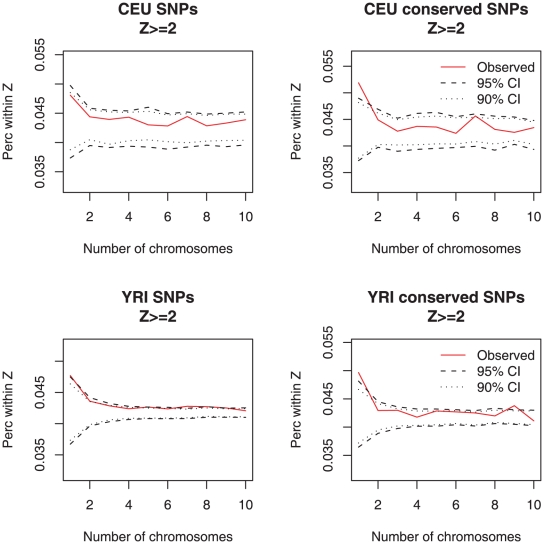
Excess of rare regulatory variants coincident with expression outliers.We calculated the excess of expression outliers as a function of frequency for all SNPs within 100 kb of the transcription start site of array-quantified genes for both Europeans and Africans. We further sub-selected to only include SNPs in 17-way most conserved elements from UCSC. We observed an enrichment of conserved singleton SNPs coincident with expression outliers (Z>2; p<0.05). The confidence intervals were estimated by randomizing expression labels 200 times.